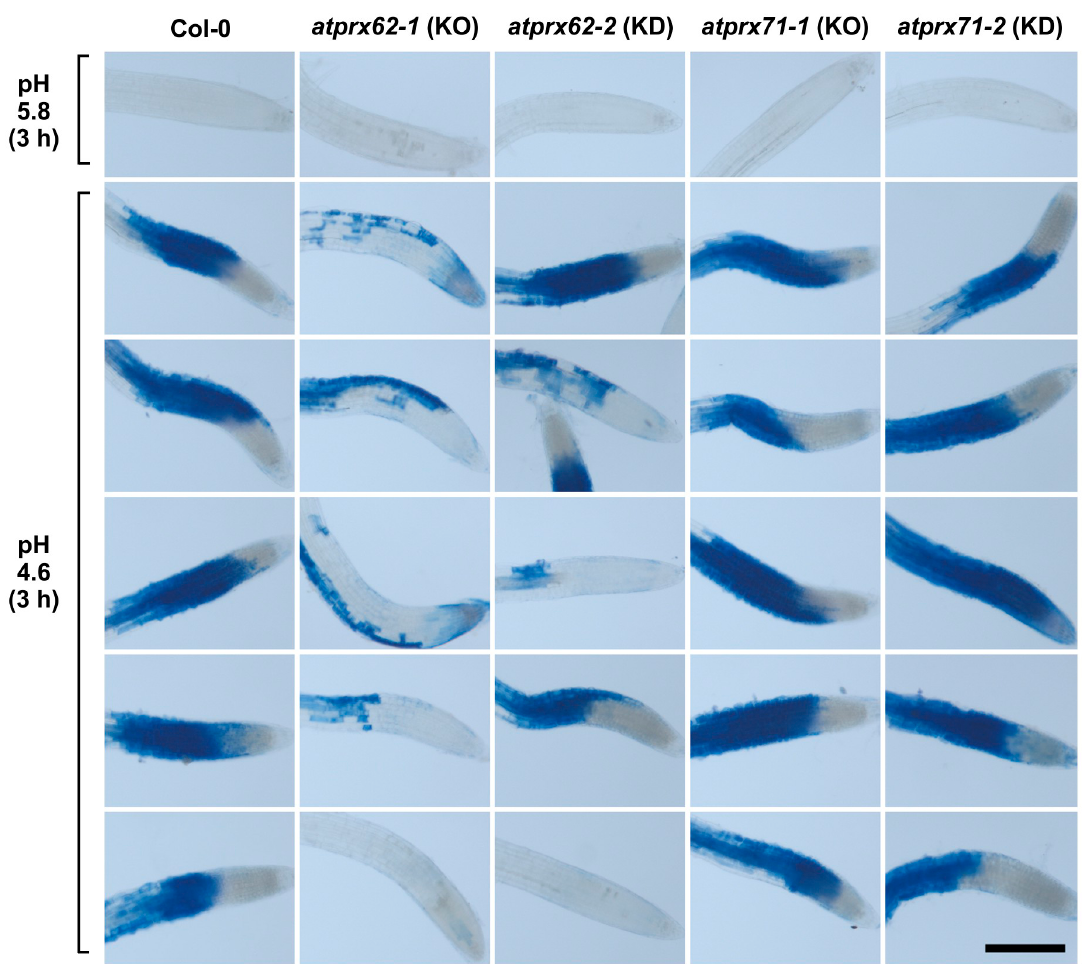
Figure 3. Analysis of low pH-induced cell death phenotypes in atprx62 and atprx71 mutants treated with strong low pH stress for 3 h. Roots treated at pH 5.8 or 4.6 for 3 h were stained with Evans blue. The blue color indicates cell mortality. From left to right: Col-0, atprx62-1 KO mutant, atprx62-2 KD mutant, atprx71-1 KO mutant, atprx71-2 KD mutant. KO: knockout; KD: knockdown; Scale bar: 200 µ m. This initial screening was performed with 10 biological replicates (roots from individual seedlings). From at least 13 roots, five representative images are shown for each genotype upon pH 4.6. Note that only atprx62-1 displayed a clear reduced cell mortality phenotype. For simplification, one image is shown for each genotype upon pH 5.8 (control), but in none of the genotypes was there cell death in these control root repeats.